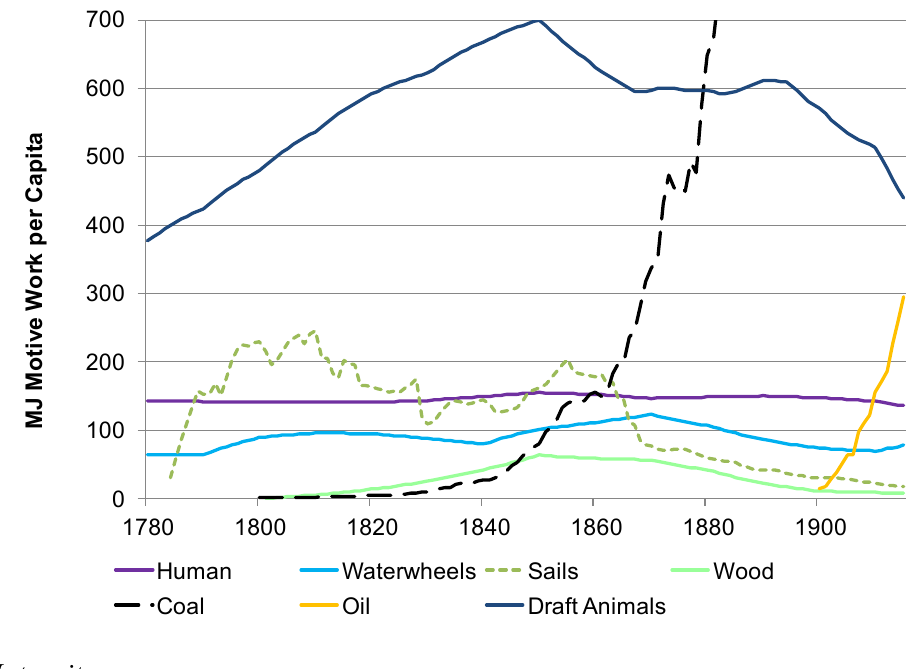
Figure 16. Mechanical work output per capita by resource, 1780–1910. Source: various; see individual energy series in Section 2. Work output calculations based on